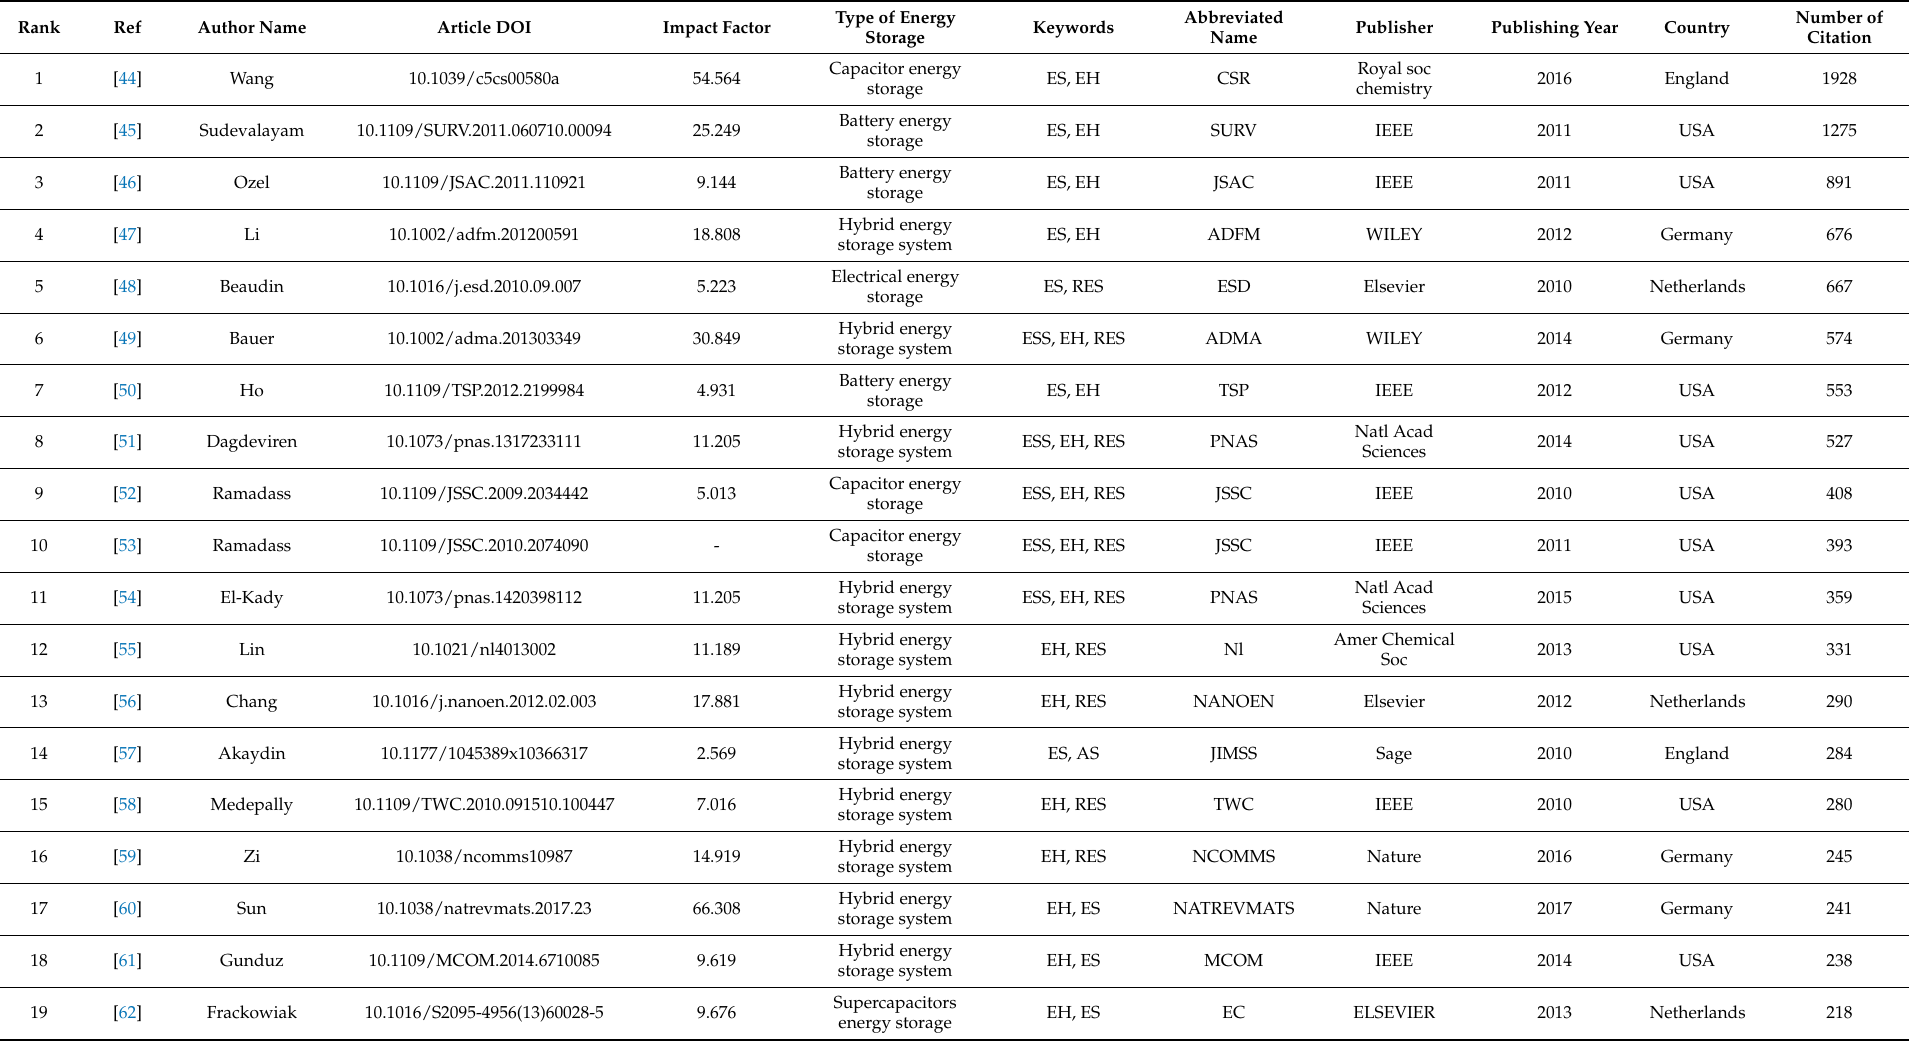
Table 1. The 130 highly-cited manuscripts in the area of energy storage as a form of renewable